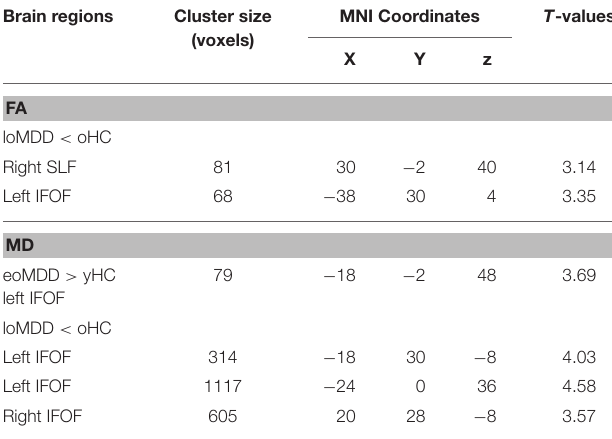
TABLE 2 | Brain regions showing significant differences between major depressive disorder and health control